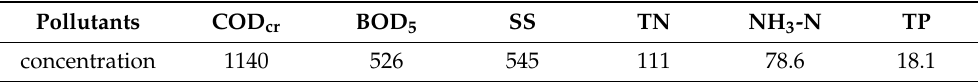
Table 1. Pollutant concentration of sewage